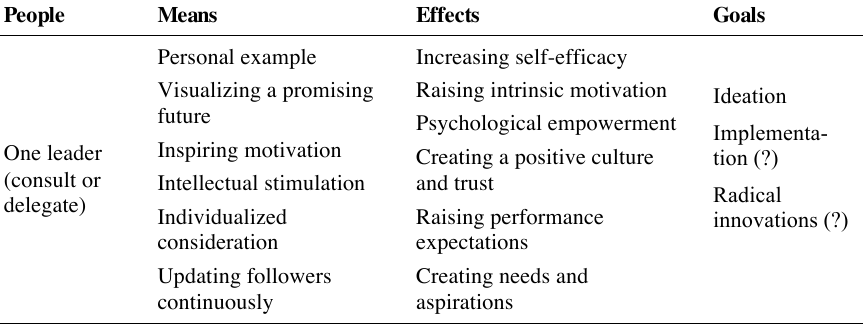
Table 5. Profile of existing research on transformational leadership (LS4). People Means Effects